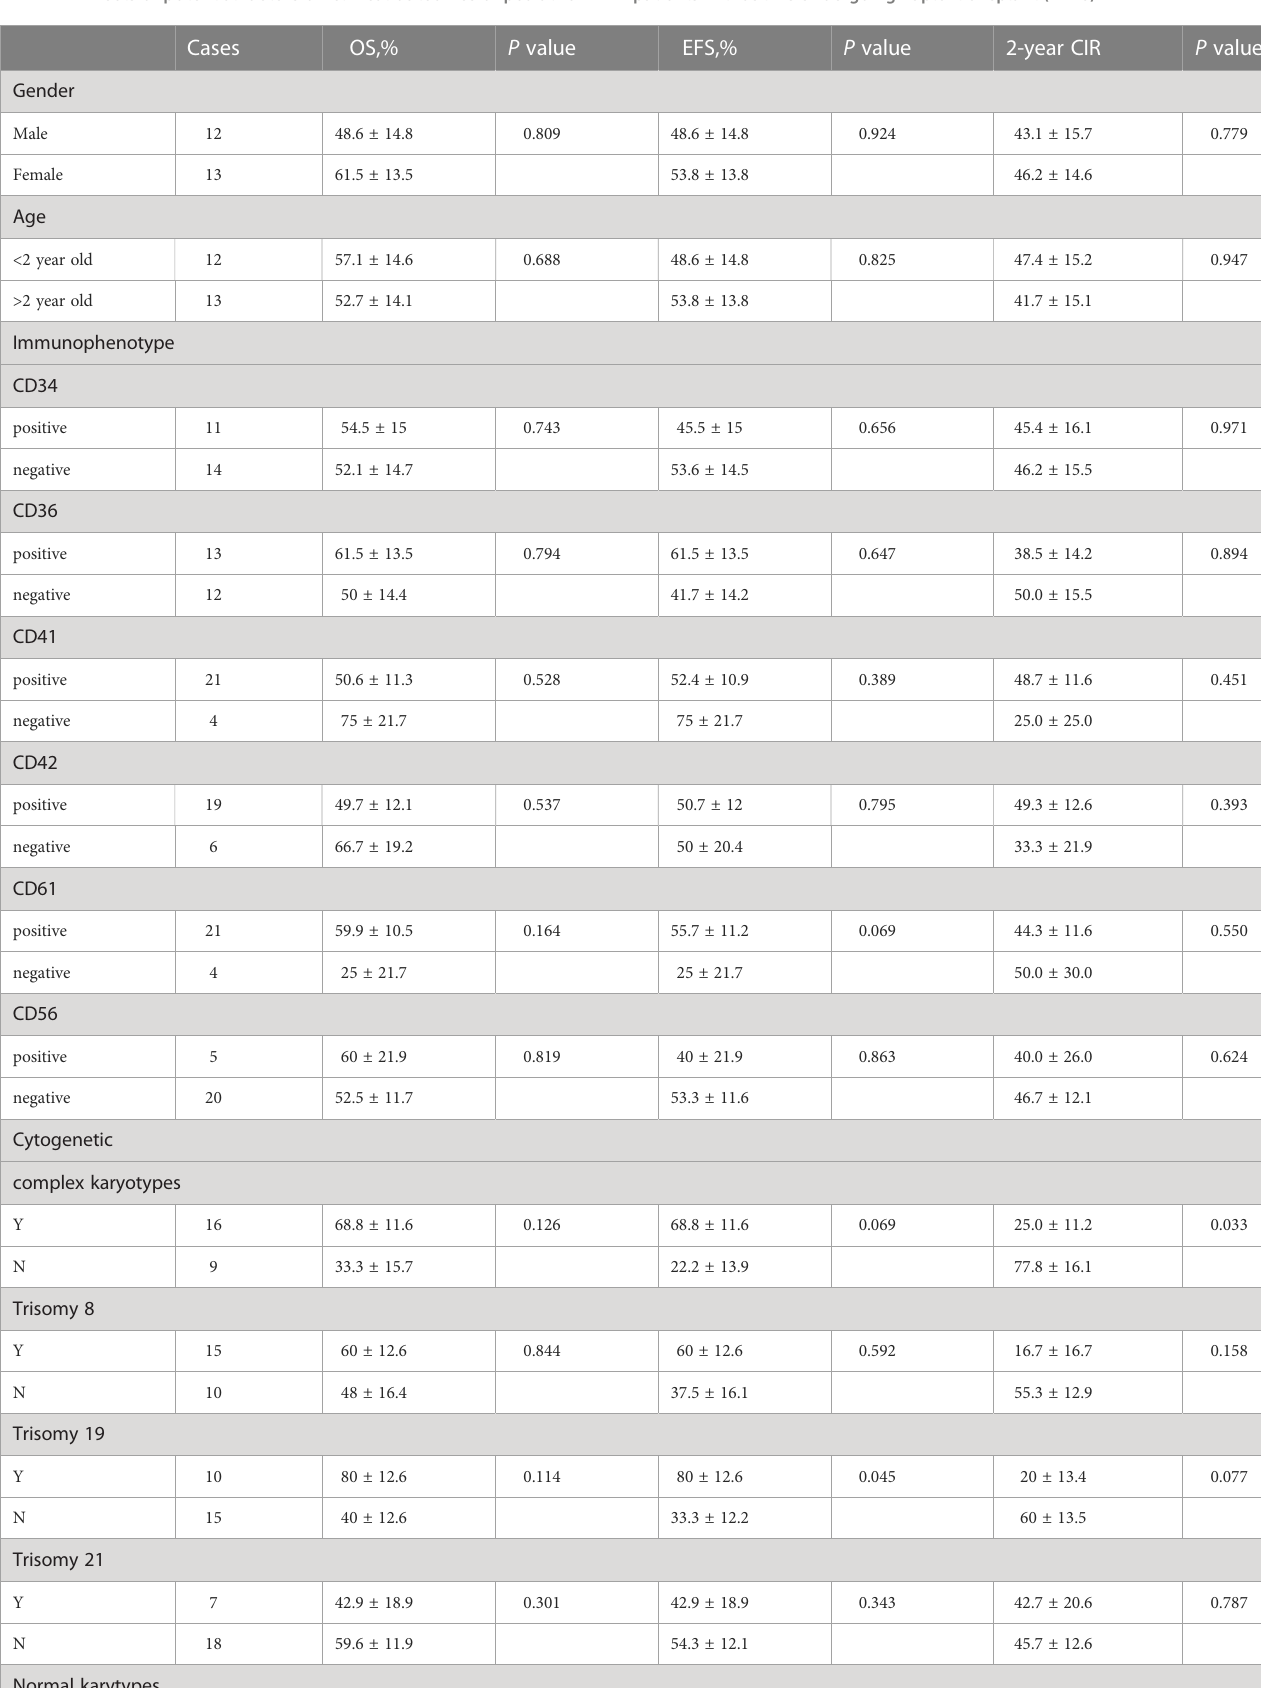
TABLE 2 Effects of potential factors on clinical outcomes of pediatric AMKL patients without DS undergoing haplo-transplant